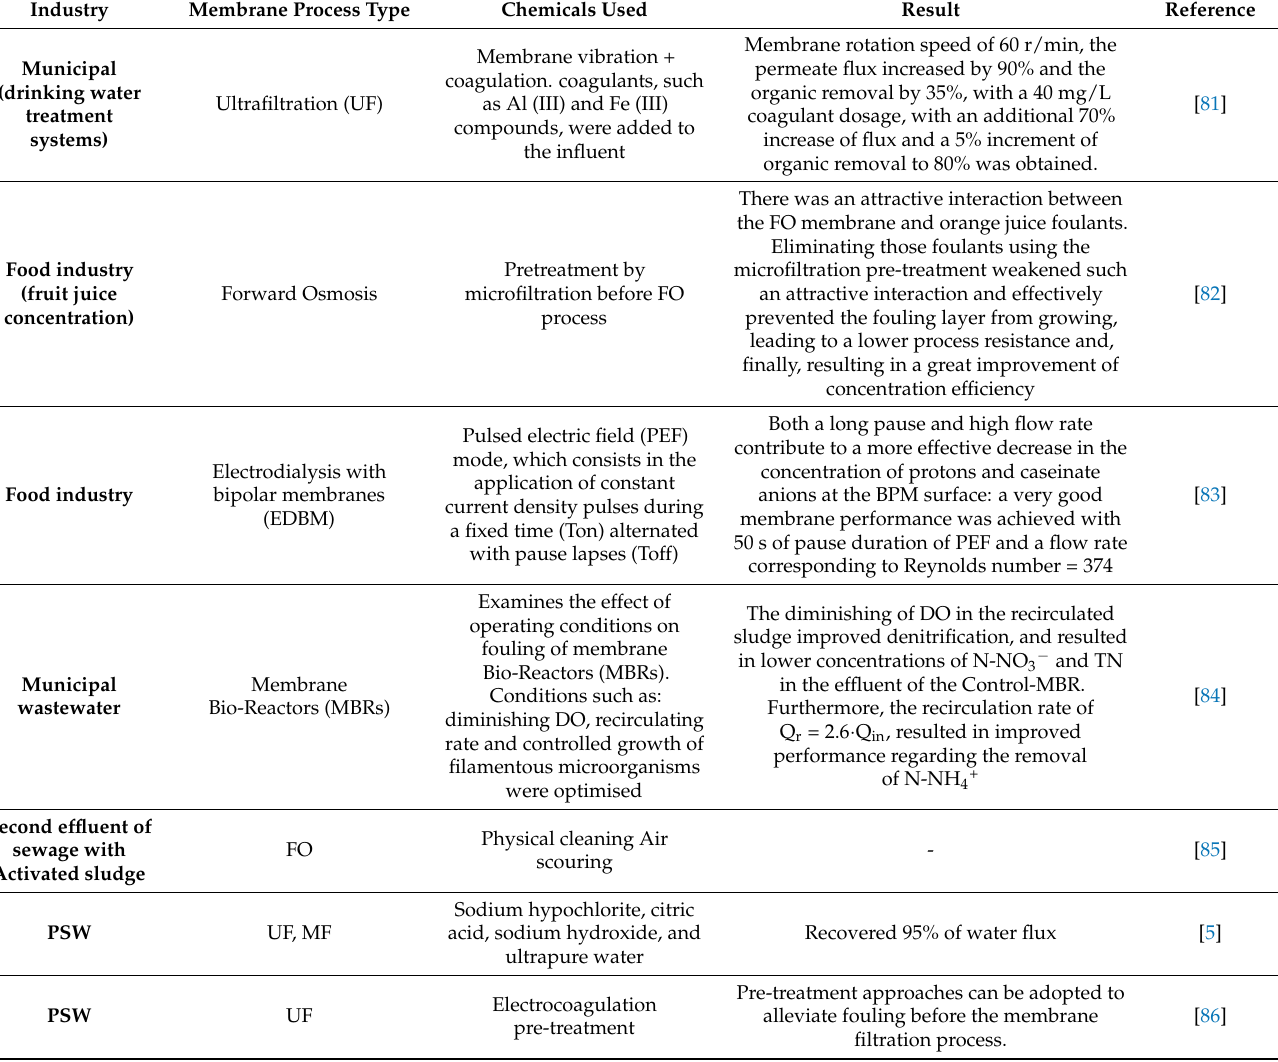
Table 4. Membrane cleaning methods used in membrane